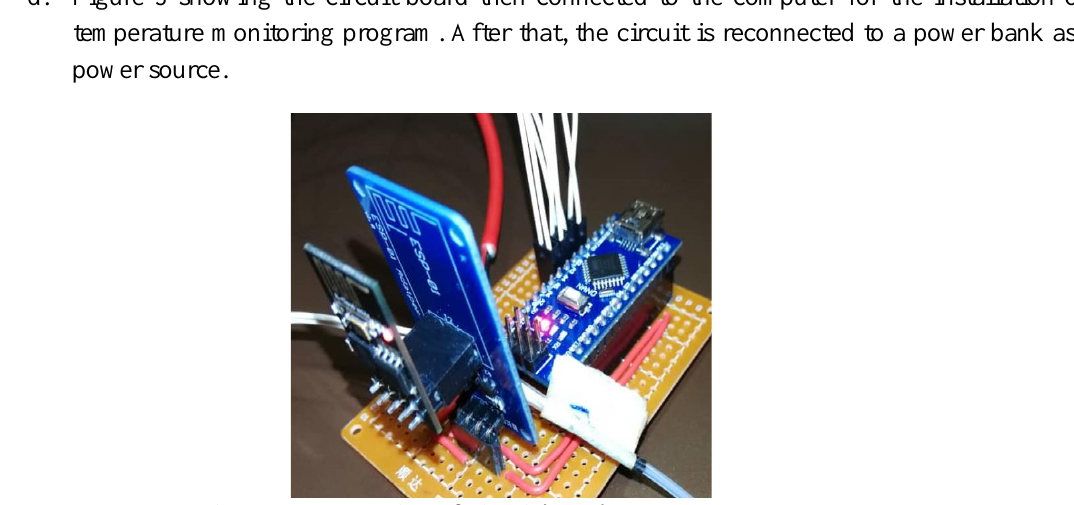
Figure 3. Connection of circuit board to a power